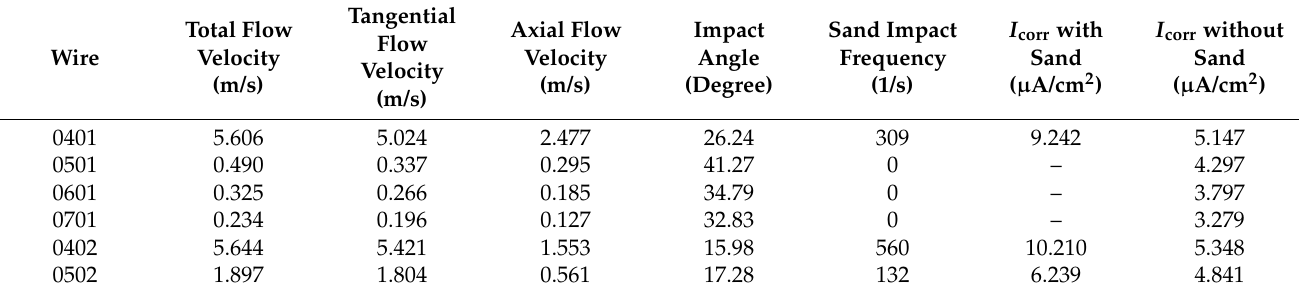
Table 2. The obtained and calculated fluid parameters and corrosion current density of each wire in the